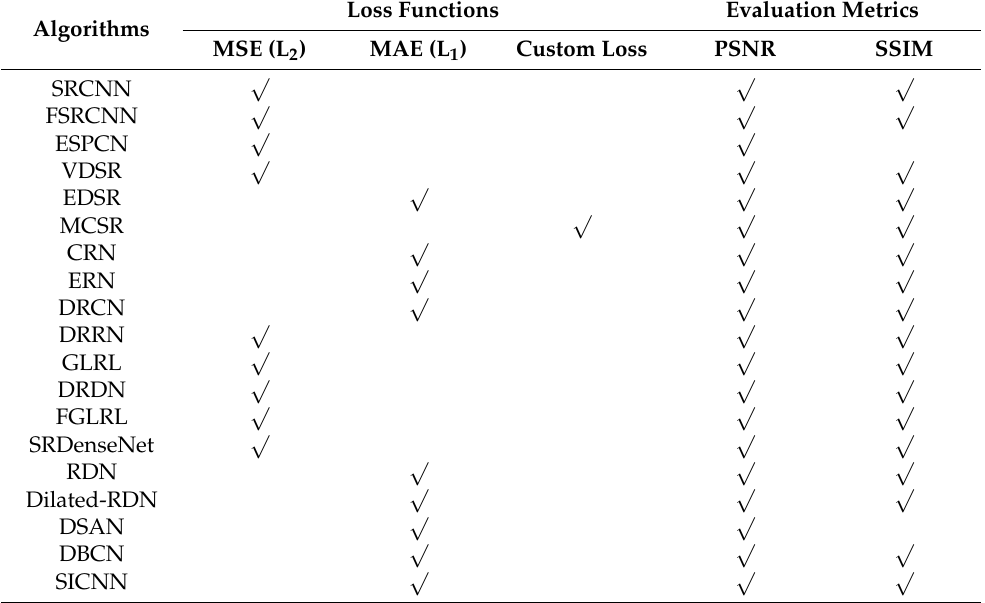
Table 3. Summary table of algorithms corresponding to their loss functions and evaluation metrics